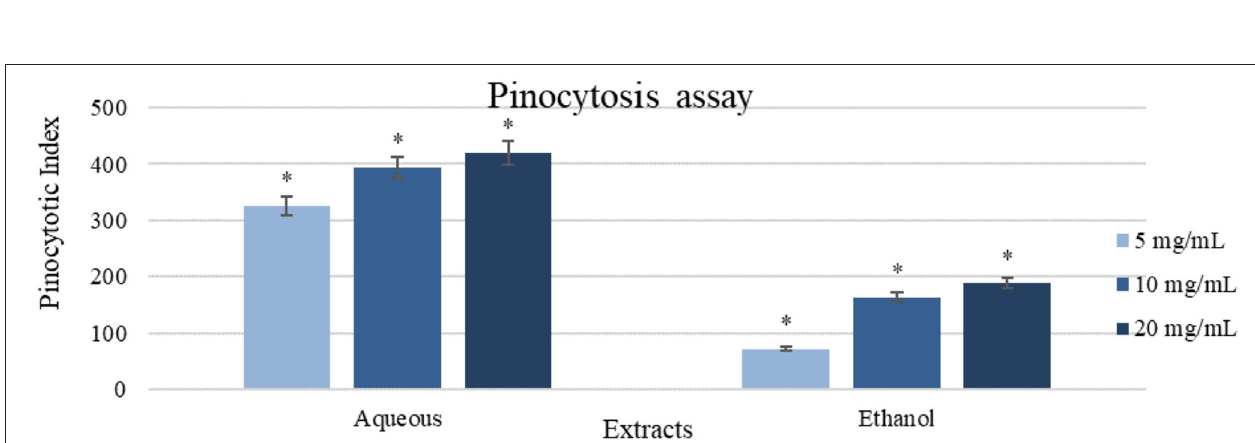
FIGURE 6 | A pinocytosis assay using the neutral red method on peritoneal macrophages treated with different concentrations of the extracts (5-20 mg/ml). Results were represented as mean (bars) ± SEM (lines), ( n = 3). * P < 0.05 (statistically significant).